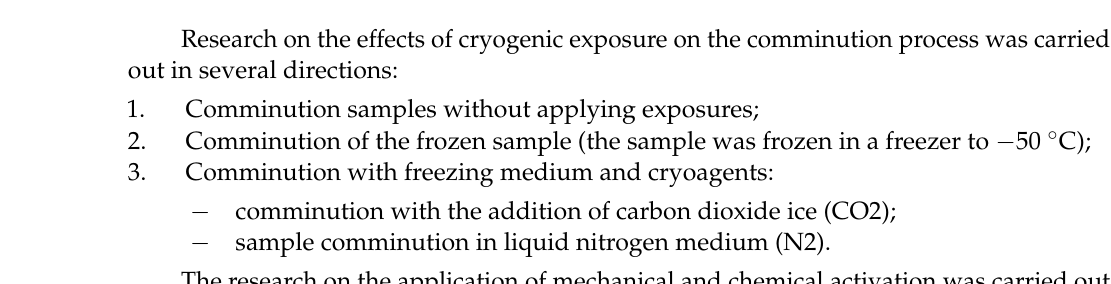
Figure 5. The scheme of the investigations into the application of low-temperature exposure ( left ) and mechanical and chemical activation ( right ). 2.2.2. Flotation Experiments